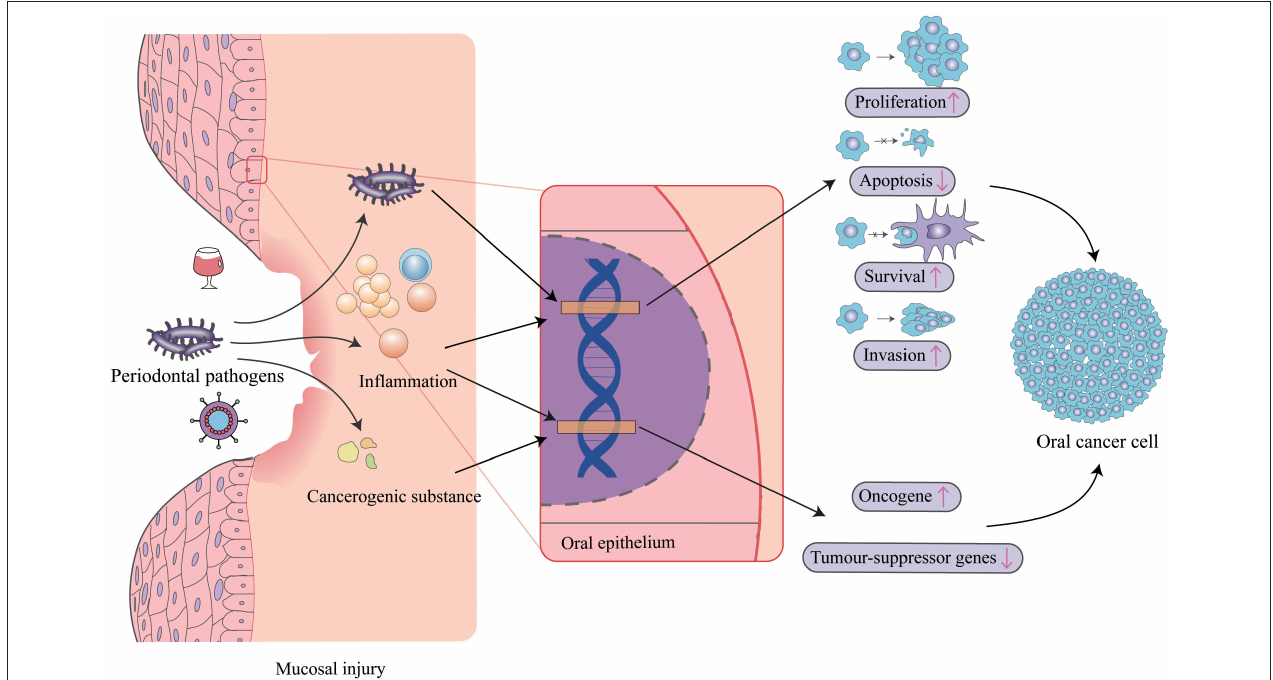
FIGURE 1 | Mechanisms of periodontal pathogens impacting oral cancer. Periodontal pathogens can invade oral epithelial cells and directly impact target genes to cause changes in cell proliferation, apoptosis, survival, and invasiveness. Pathogens also triggers inflammation, which also affects these biological pathways, and similarly acts on oncogenes and tumor-suppressor genes, as do some cancerogenic substances produced by periodontal pathogens. In addition, inflammation sequentially induces mucosal injury leading to susceptibility to virus and other carcinogens like